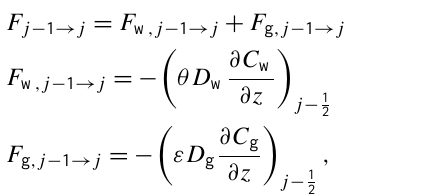
Figure 1. Schematic of the dual-phase diffusive transport prob- lem: solid lines are the interfaces between control volumes and the dashed line is the center of the control volume. All symbols are de- fined in Appendix Table